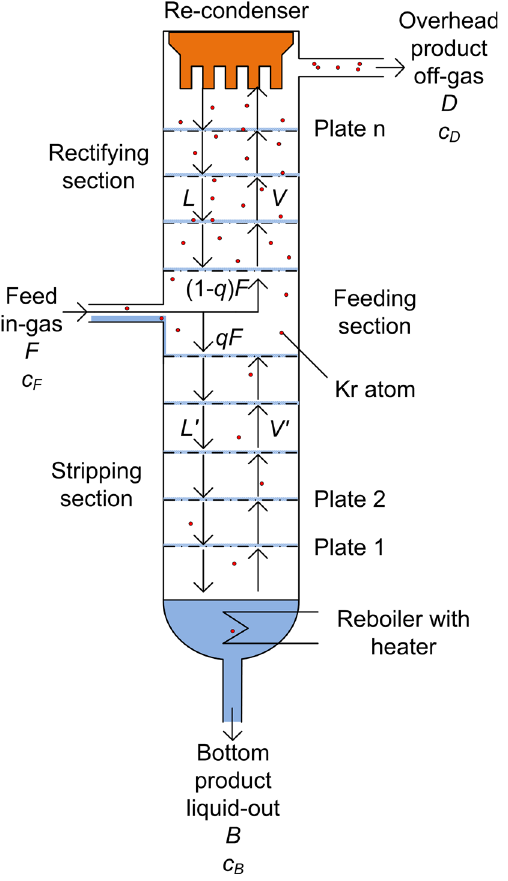
Fig. 1 Schematics of a distillation column with partial reflux. In this diagram, the typical construction of a distillation column using several distillation plates and partial reflux is shown. It consists of three parts, the stripping section, the feeding section and the rectifying section. L and L (cid:5) are the down-going liquid streams while V and V (cid:5) are the up- going gaseous streams in the different parts. Both are connected to the feeding stream F . The krypton enriched off-gas stream D is extracted from the top while the purified xenon is extracted from the bottom with a flow rate B . The krypton in xenon concentrations of the feed and the two extraction flows are given by c F , c D and c B , while q defines the state of matter of the injected